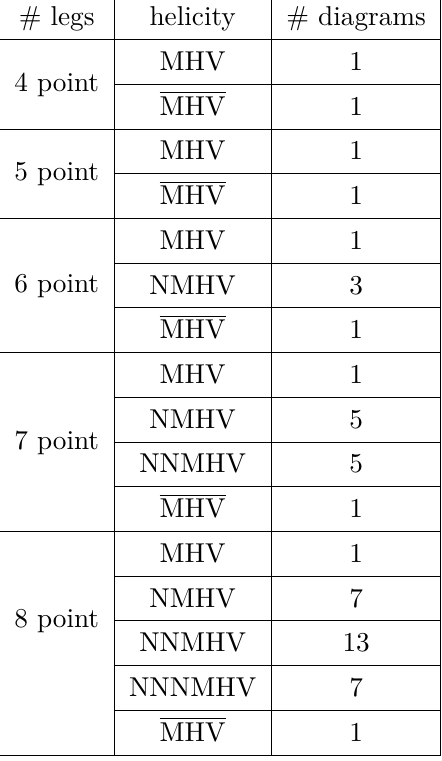
Table 1 . Total number of diagrams for helicity amplitudes of different multiplicities. field Z ? is given by the straight infinite Wilson line on the anti-self-dual plane (i.e. the